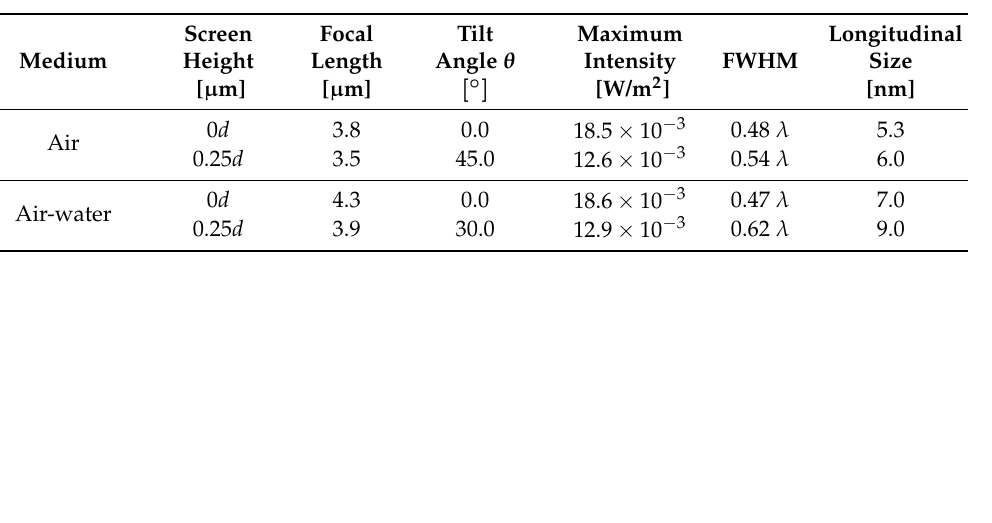
Table 1. Photonic Jet formation via illumination on 6 µ m silica microcylinder in air. vs.